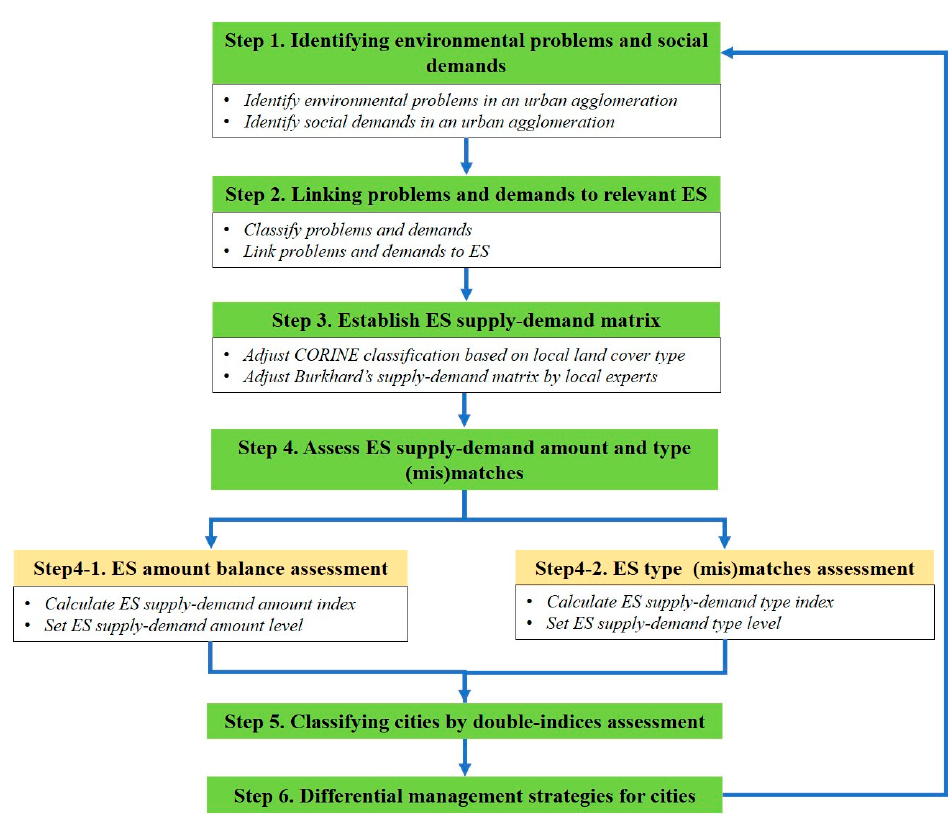
Figure 1. A general ES framework with six core steps for differential city management.